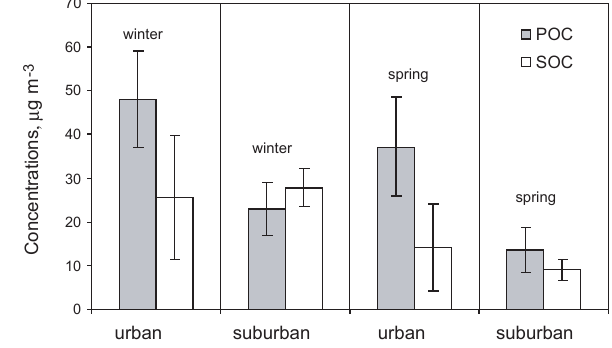
Fig. 3. Concentrations of primary organic carbon (POC) and sec- Fig. 3 Concentrations of primary organic carbon (POC) and ondary organic carbon (SOC) in the urban and suburban atmo- secondary organic carbon (SOC) in the urban and suburban atmosphere